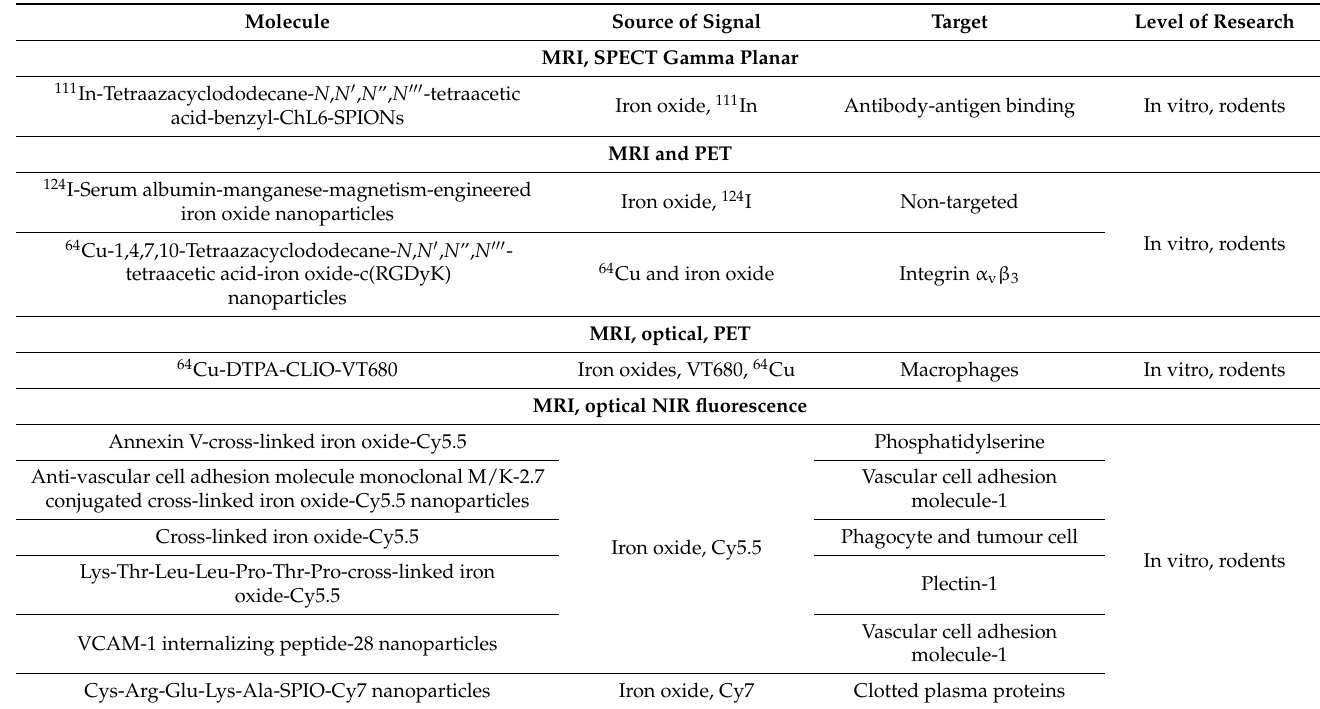
Table 3. Iron oxide based multimodal contrast agents as described in MICAD